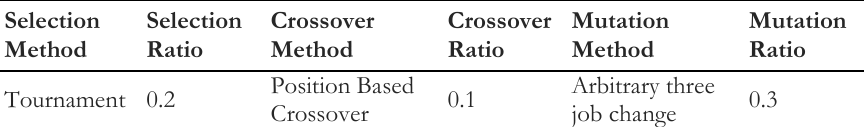
Table 3. The BPS of Engin and Gözen [29]’s